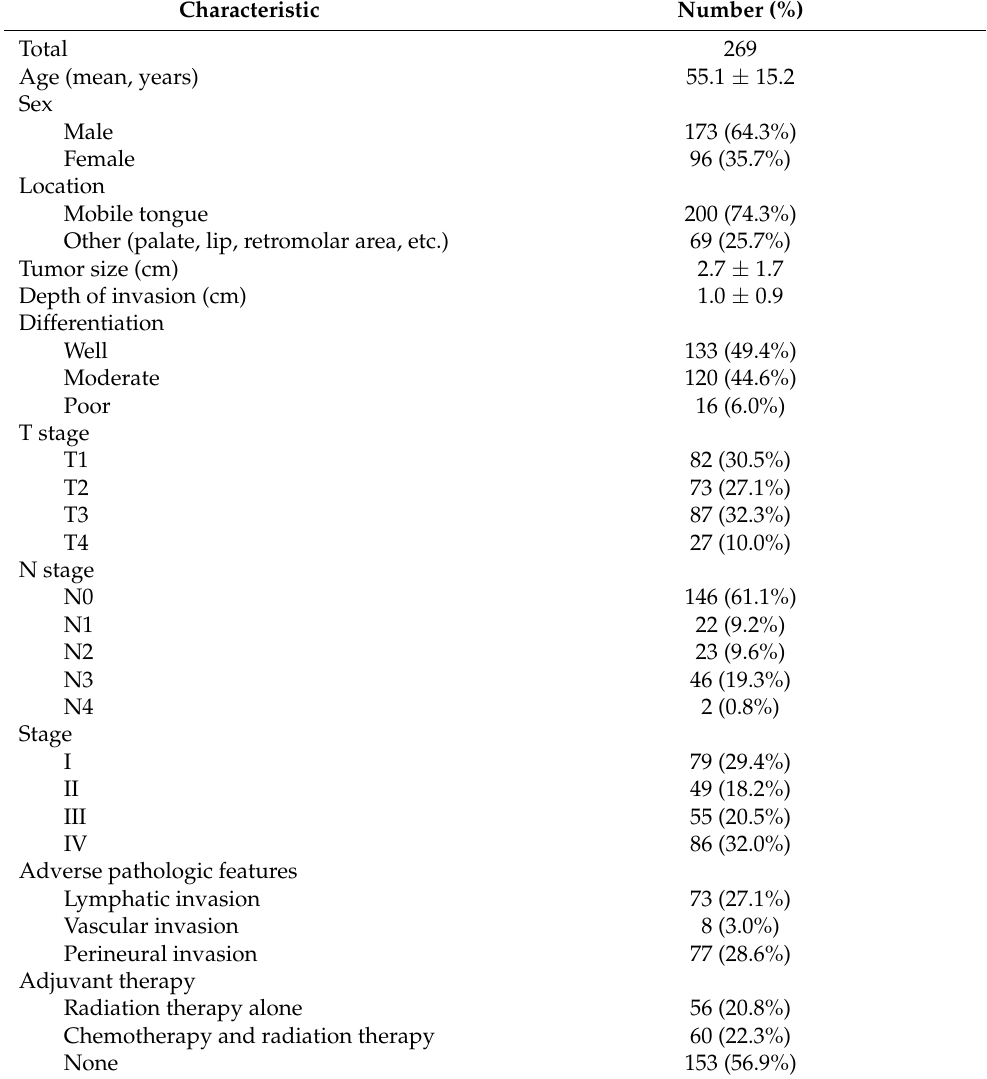
Table 2. Clinicopathologic characteristics of patients with oral squamous cell